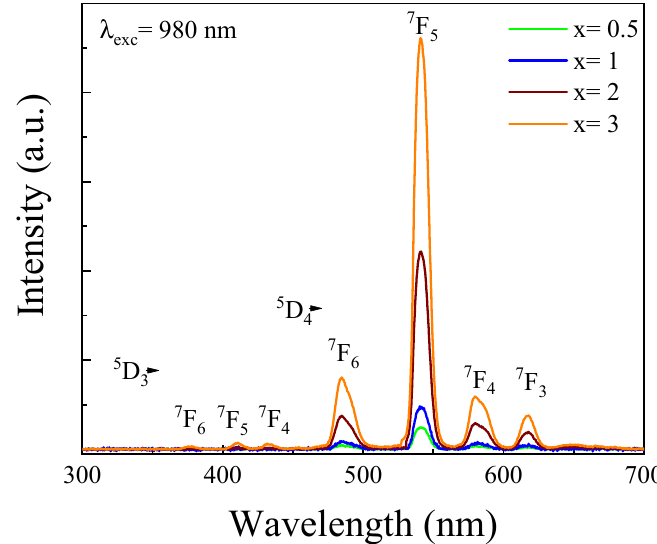
3+ -xYb 3+ co-doped phosphate